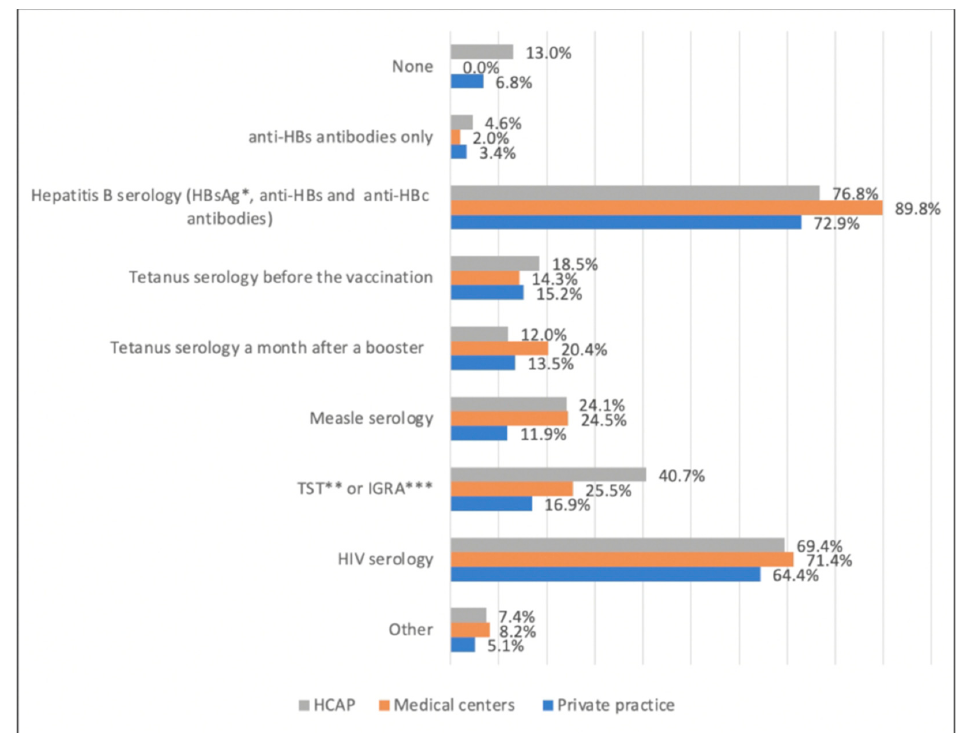
Figure 2. Use of pre-vaccinal serological test by 216 French general practitioners for a 35-year-old Syrian man (2017–2018). * HBsAg: hepatitis B virus surface antigen, ** TST: tuberculin skin test, *** IGRA: interferon-gamma-release assays. Table 1. Results of logistic regression models estimating the association between carrying out a systematic full primary series of vaccines and general practitioner’s profile, among 219 general practitioners interviewed in France